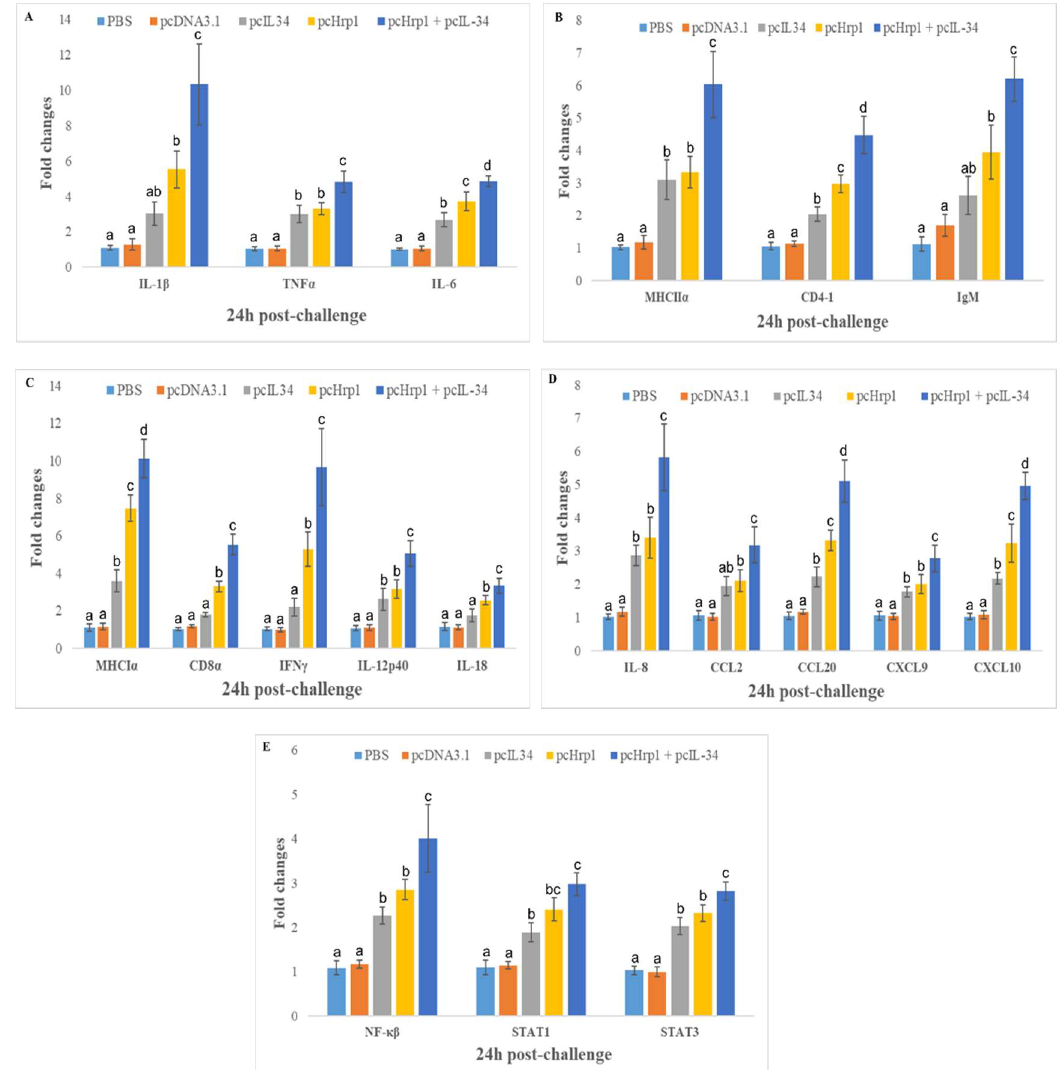
Figure 10. mRNA expression levels of immune-related genes in vaccinated and control fish at 24 h post N. seriolae challenge using qRT-PCR. ( A ) Pro-inflammatory cytokines (IL-1 β , TNF α , IL-6); ( B ) humoral immunity mediators (MHCII α , CD4-1, IgM); ( C ) cellular immunity mediators (MHCI α , CD8 α , IFN γ , IL-12p40, IL-18); ( D ) chemokines (IL-8, CCL2, CCL20, CXCL9, CXCL10); ( E ) transcriptional factors (NF- κ B, STAT1, STAT3). Data are presented as means ± SD (n = 8). a,b,c,d A significant di ff erence ( p < 0.05) exists between groups with di ff erent superscript